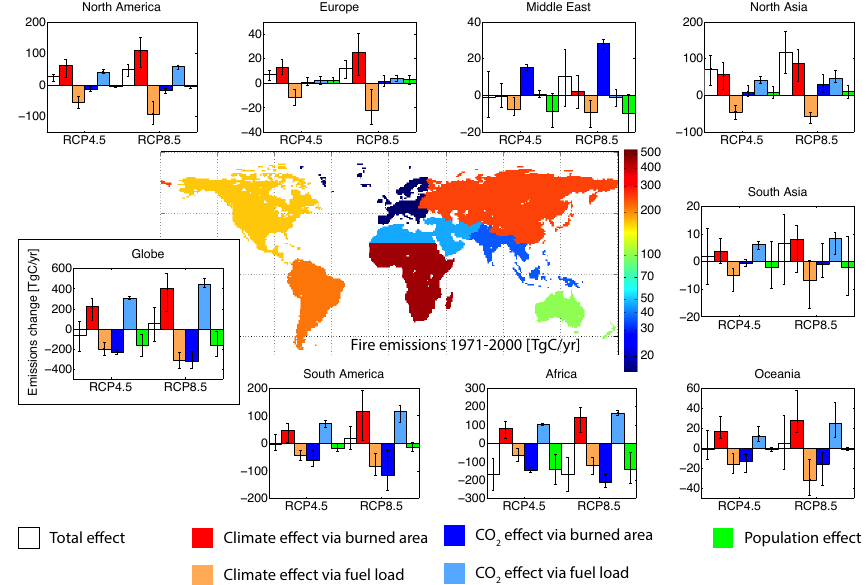
Figure 5. As previous figure, but for average emissions during 1971–2000 and changes as 2071–2100 minus 1971–2000 averages, both differentiated between RCP4.5 and RCP8.5 climate scenarios. In this case, the ensemble is across 8 ESMs times 5 population